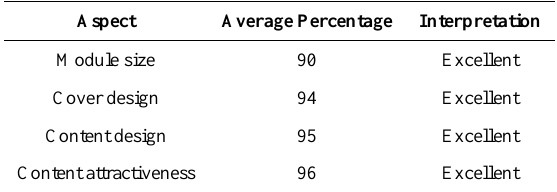
Table 3. Expert validation result on